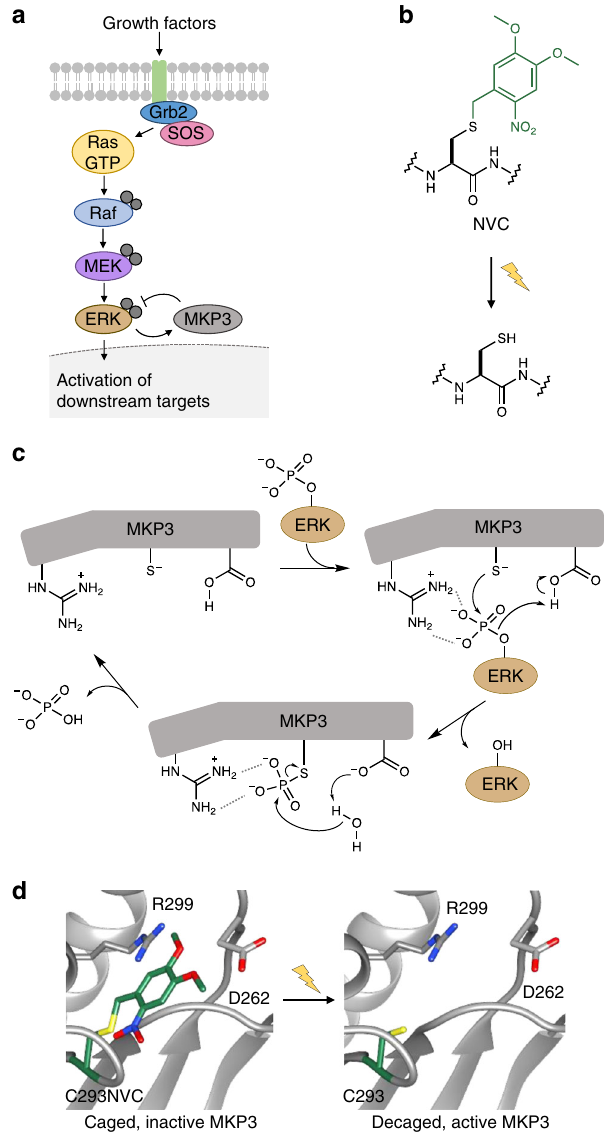
Fig. 1 Overview of the MAPK/MKP3 signaling network and application of caged cysteine toward caging the catalytic site of the phosphatase. a Schematic of the Ras/Raf/ERK signaling pathway with the dual-speci fi city phosphatase MKP3 indicated in grey. Upon activation of the pathway by external stimuli, a cascade of phosphorylation events results in dually- phosphorylated ERK, which translocates to the nucleus where it activates additional downstream targets. In the presence of active MKP3, pERK is rapidly dephosphorylated and remains in the cytoplasm. Phosphates are indicated by grey fi lled circles. b Irradiation of NVC removes the nitrobenzyl caging group (green) and restores a native cysteine residue. c The mechanism of MKP3-catalyzed ERK dephosphorylation. Dashed lines indicate electrostatic and/or hydrogen-bond interactions. d The crystal structure of MKP3 (PDB: 1MKP) is shown with the three critical active site residues labeled in black. On the left, the catalytic cysteine was replaced with NVC, which sterically blocks the active site and prevents catalysis, until exposed to 365 nm